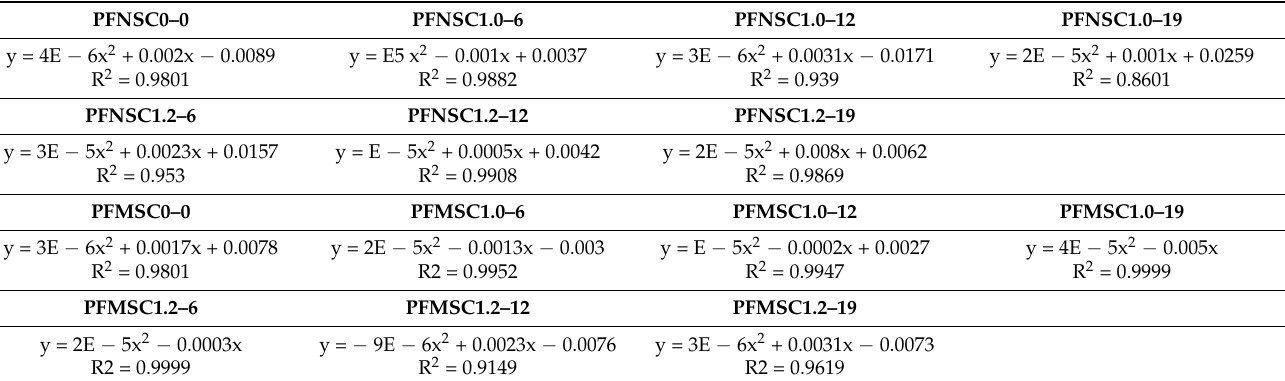
Table 5. Fit function of split-pull strength damage